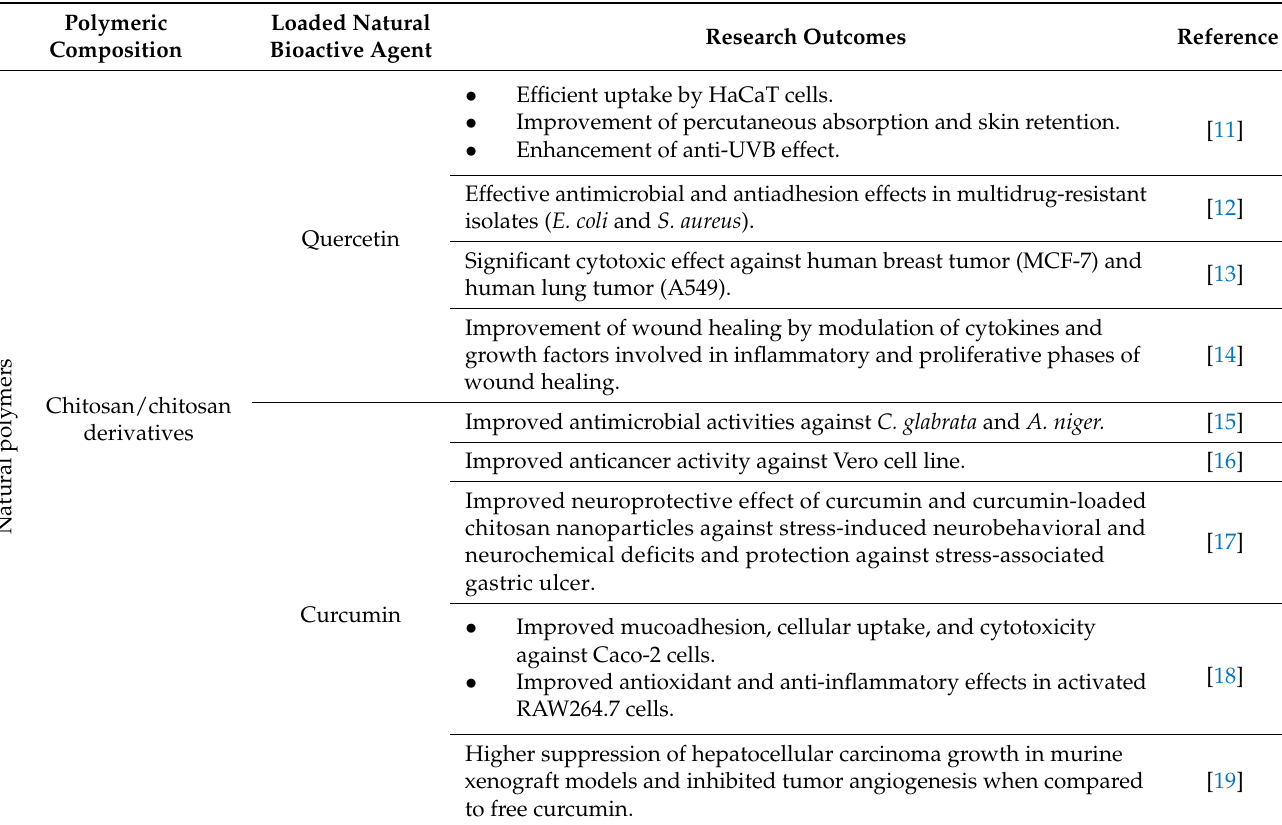
Table 1. Examples of recent studies utilizing natural polymer-based polymeric nanoparticles for loading natural bioactive agents.